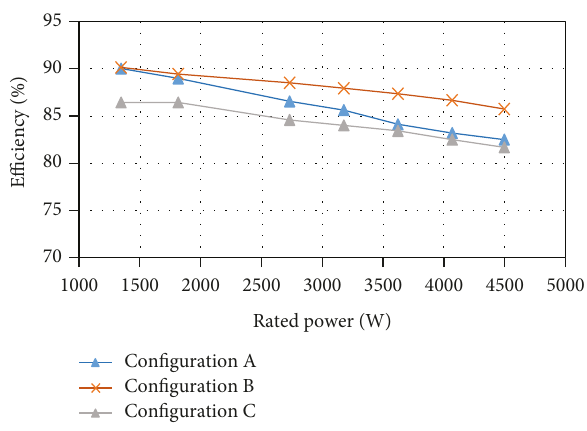
Figure 10: E ffi ciency comparison.